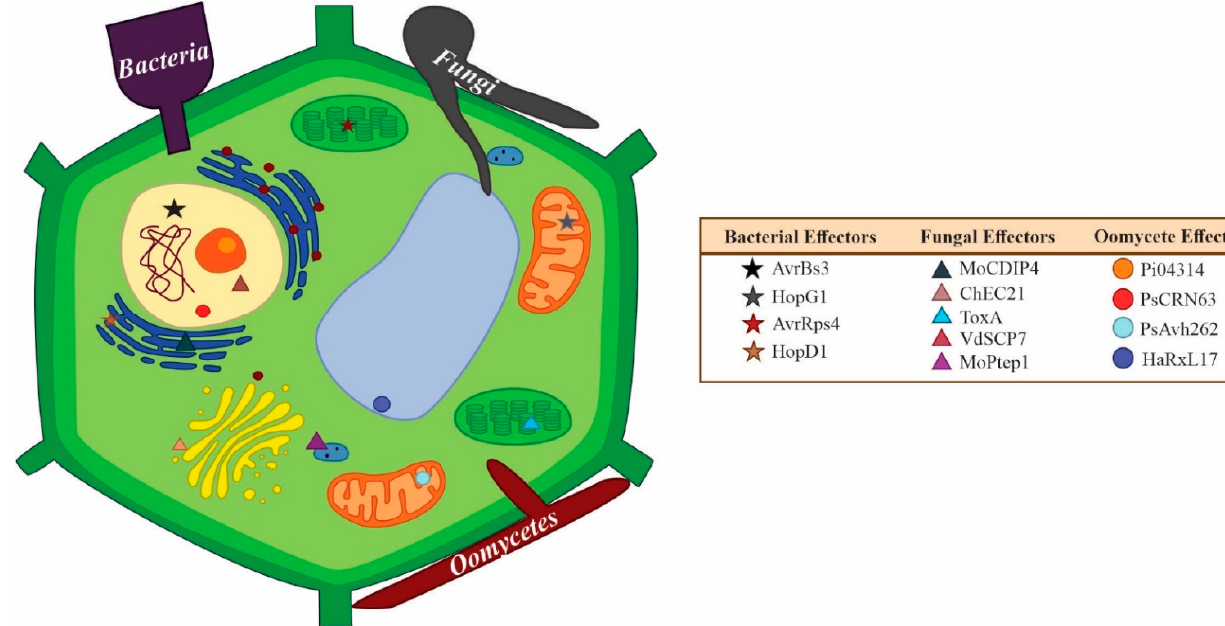
Figure 2. Examples of effectors and their intracellular targets. Secreted effectors enter the cell apoplast before they reach the interior of the cell; some are retained in the apoplast if their targets are apoplastic while others traverse the cell membrane to reach their targets inside the cell. In the intracellular bacterial effector examples given, the effectors AvrBs3 [159], HopG1 [160,161], AvrRps4 [86,162], and HopD1 [163] target the nucleus, mitochondria, chloroplast, and endoplasmic reticulum (ER), respectively. The fungal effectors displayed are AvrSr35 [164], ChEC21 [156], ToxA [165], VdSCP7 [166], and MoPtep1 [167] which target the ER, Golgi, chloroplast, nucleus, and peroxisomes, respectively. The oomycetes effectors Pi04313 [150] and PsCRN63 [168,169] target the nucleus while PsAvh262 [170] targets the mitochondria and HaRxL17 [171] associates with the plant tonoplast (vacuolar membrane). Table 2. Examples of intracellular effectors with experimentally proven locations. With respect to effector targets, some effectors have been found to have more than one target in an organism, like AvrLm4-7 of Leptosphaeria maculans which interacts with multiple R genes in Brassica napus [187]. On the other hand, a target may interact with multiple effectors of the same pathogen like the RGA4/RGA5 receptor pair in rice that is recognized by AVR-Pia and AVR1-CO39 of Magnaporthe oryzae [139]. Furthermore, one target may have interactions with several effectors of different organisms; the Rcr3 protease of tomato is targeted by the Avr2 effector of Cladosporium fulvum and two other effectors, EPIC1 and EPIC2B of Phytophthora infestans [188]. These targets in the host that